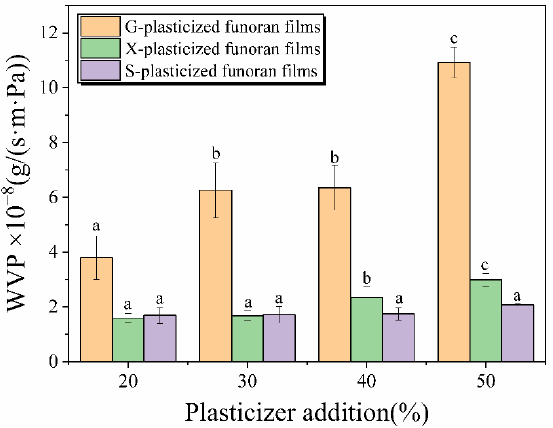
Figure 8. Effects of G, X and S addition on water vapor barrier property of the funoran films. The different superscript letter (a–c) indicates significant difference.